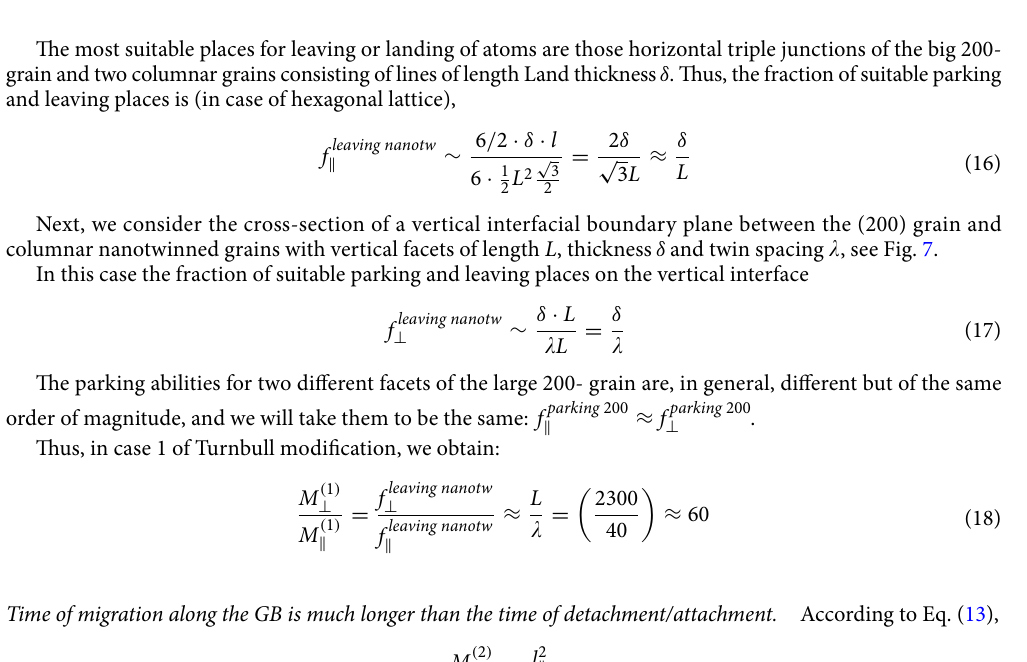
Figure 7. Difference of leaving/parking places at the “vertical” and “horizontal” boundaries of the 200